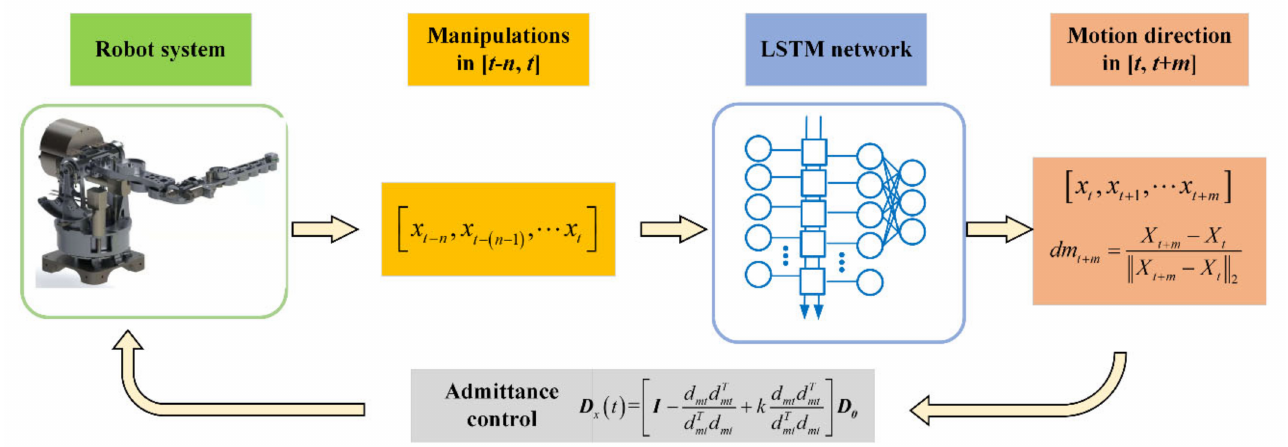
Figure 1. Overview of the control system consisting of a robot system, a LSTM network, and an admittance control